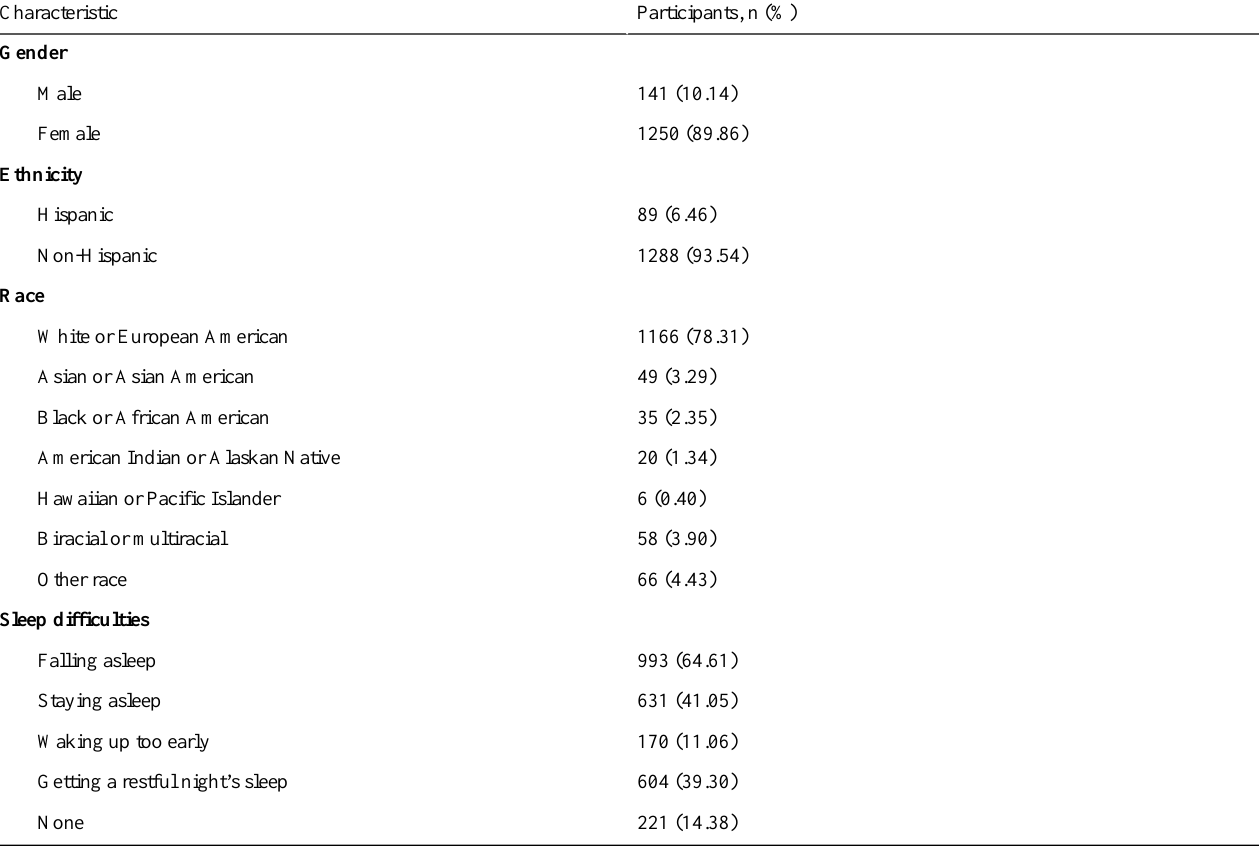
Table 1. Characteristics of parents whose children used